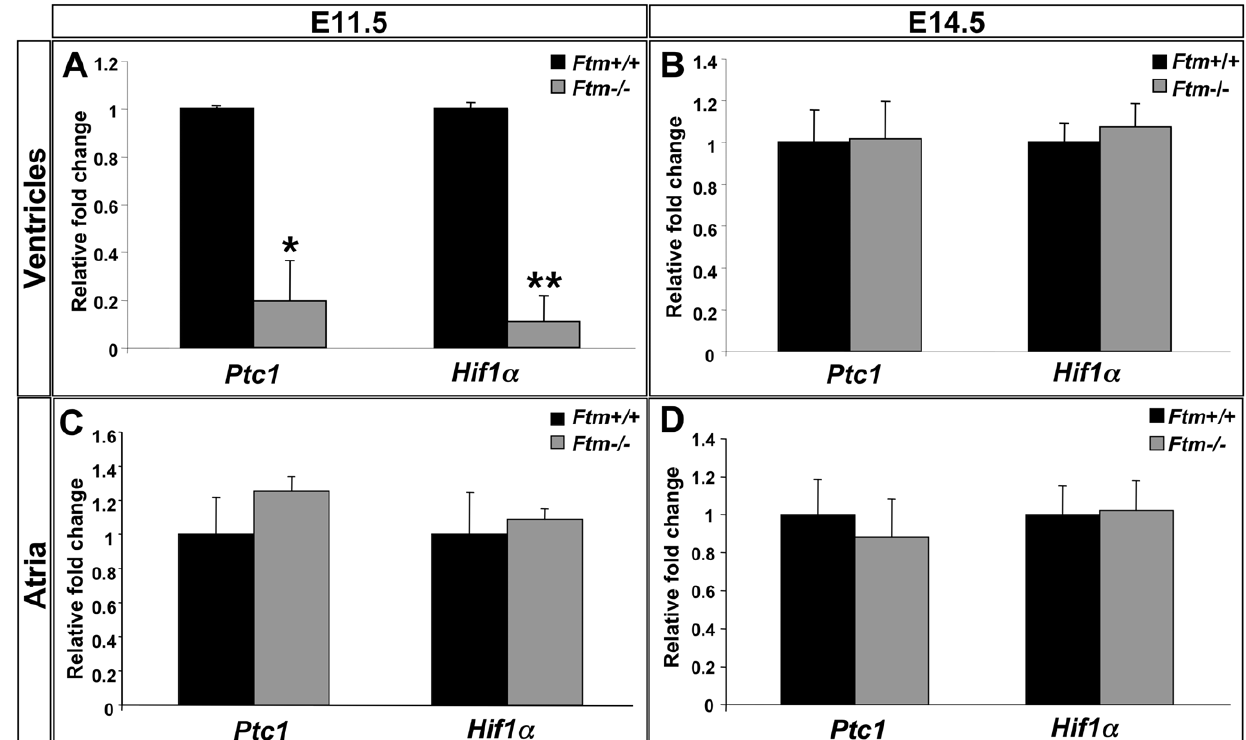
Figure 5. Shh and Pdgfr a signals are downregulated in Ftm -negative murine hearts. (A–D) Real-time PCR analysis of wild-type and Ftm - deficient ventricular (A, B) and atrial tissue (C, D) at E11.5 (A, C) and E14.5 (B, D). (A) Shh target gene expression of Ptc1 and Pdgfr a target gene expression of Hif1 a are significantly downregulated in E11.5 Ftm 2 / 2 ventricles (n=3, respectively; Ptc1 : p=0.013; Hif1 a : p=0.005). (B) At E14.5, both signaling pathways are unaffected in Ftm -negative ventricles (n=6, respectively). (C, D) In Ftm 2 / 2 atria, Shh and Pdgfr a signaling are not significantly altered at E11.5 (n=6 atria, respectively; C) and at E14.5 (n=6 atria, respectively; D).